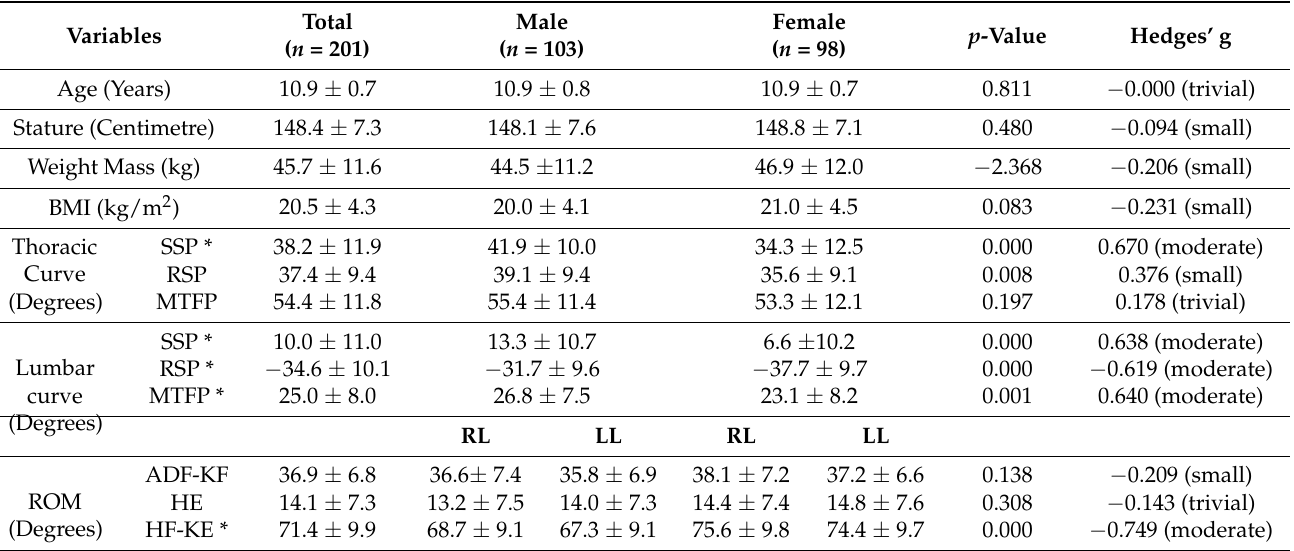
Table 1. Age, anthropometry, spinal curves angles, and hip–knee range of motion outcome data (mean ± SD) of the children included in the study ( n =